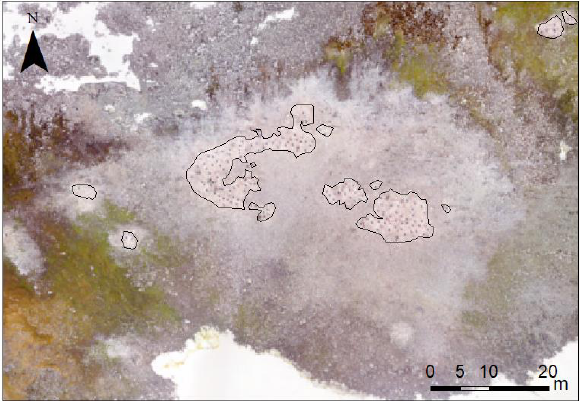
Figure 2. UAV orthomosaic of penguin nest groups showing the areas of fresh guano (inside black